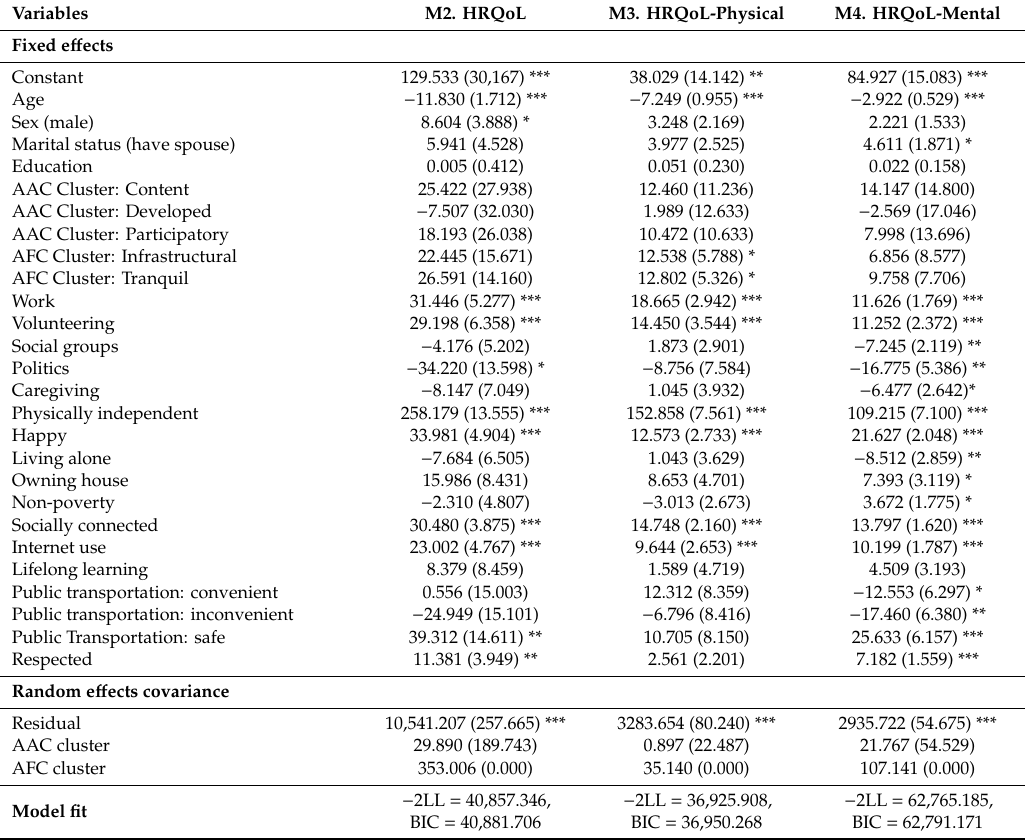
Table 5. Health-related quality of life with city clusters and individual factors of older adults (aged 65 + ).